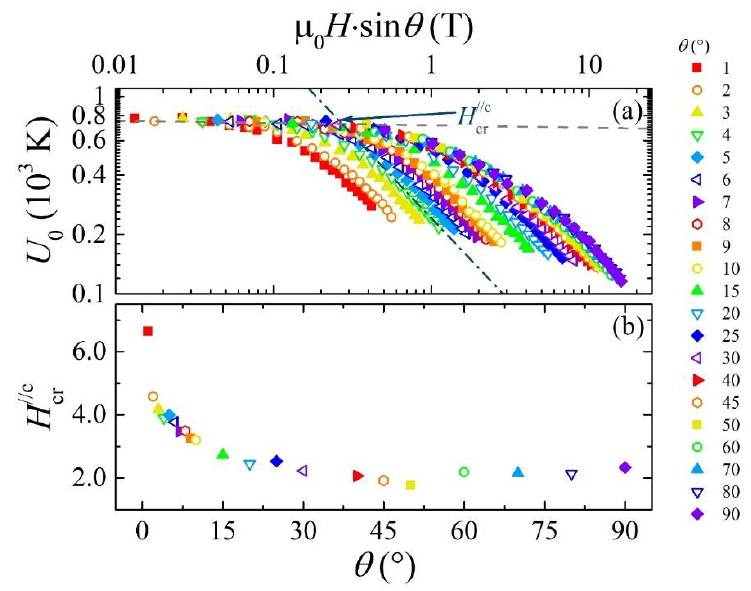
Figure 6. ( a ) Flux pinning energy for several magnetic fields and angles as a function of the per- pendicular component of the applied field. ( b ) The crossover field perpendicular component at all measured angles.